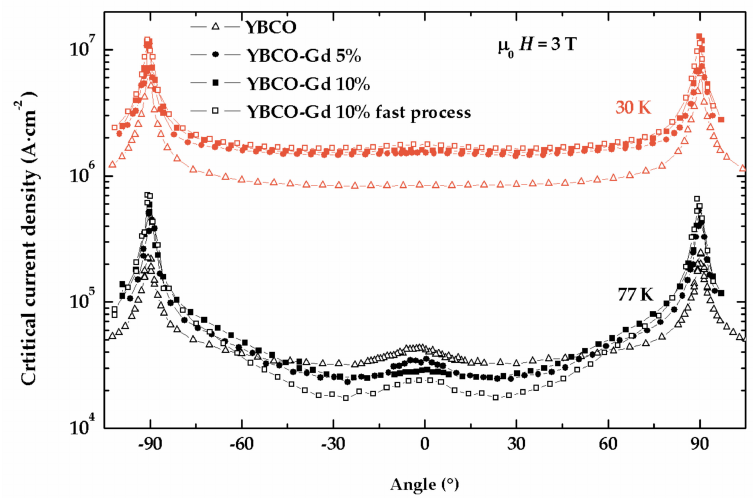
Figure 10. Angular dependence of J c at 77 and 30 K and applied field value of 3 T recorded for pristine YBCO (open triangle), YBCO-Gd 5% (full circle), and YBCO-Gd 10% (full square) films deposited with the standard process and YBCO-Gd 10% (open square) film deposited with the fast process. Zero degrees correspond to the field orientation, parallel to the YBCO c